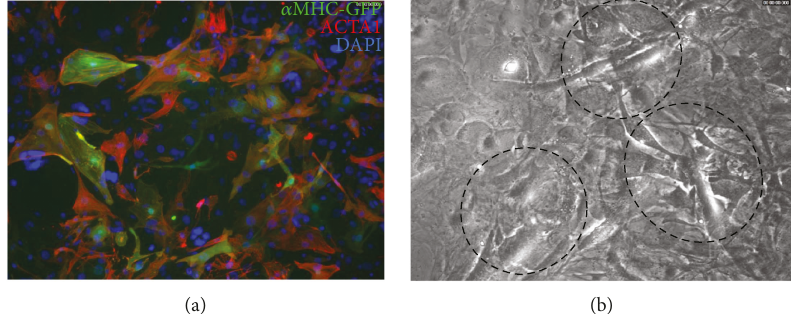
Figure 1: GMT+ A83-01 reprogramming in MEFs. (a) Immunocytochemistry for the cardiac markers α MHC-GFP and α -actinin (ACTA1). (b) Video snapshot showing beating areas of reprogrammed cells (outlined